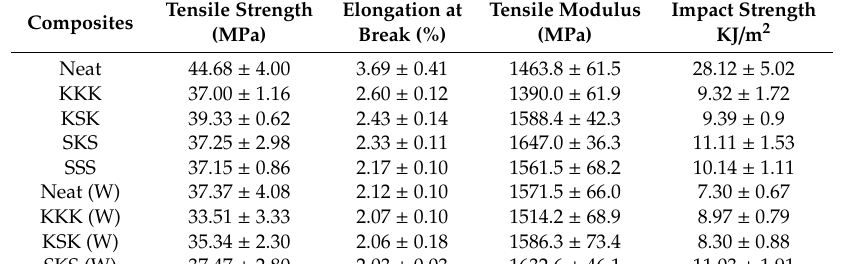
Table 1. The tensile and impact properties of epoxy composite before and after weathering.